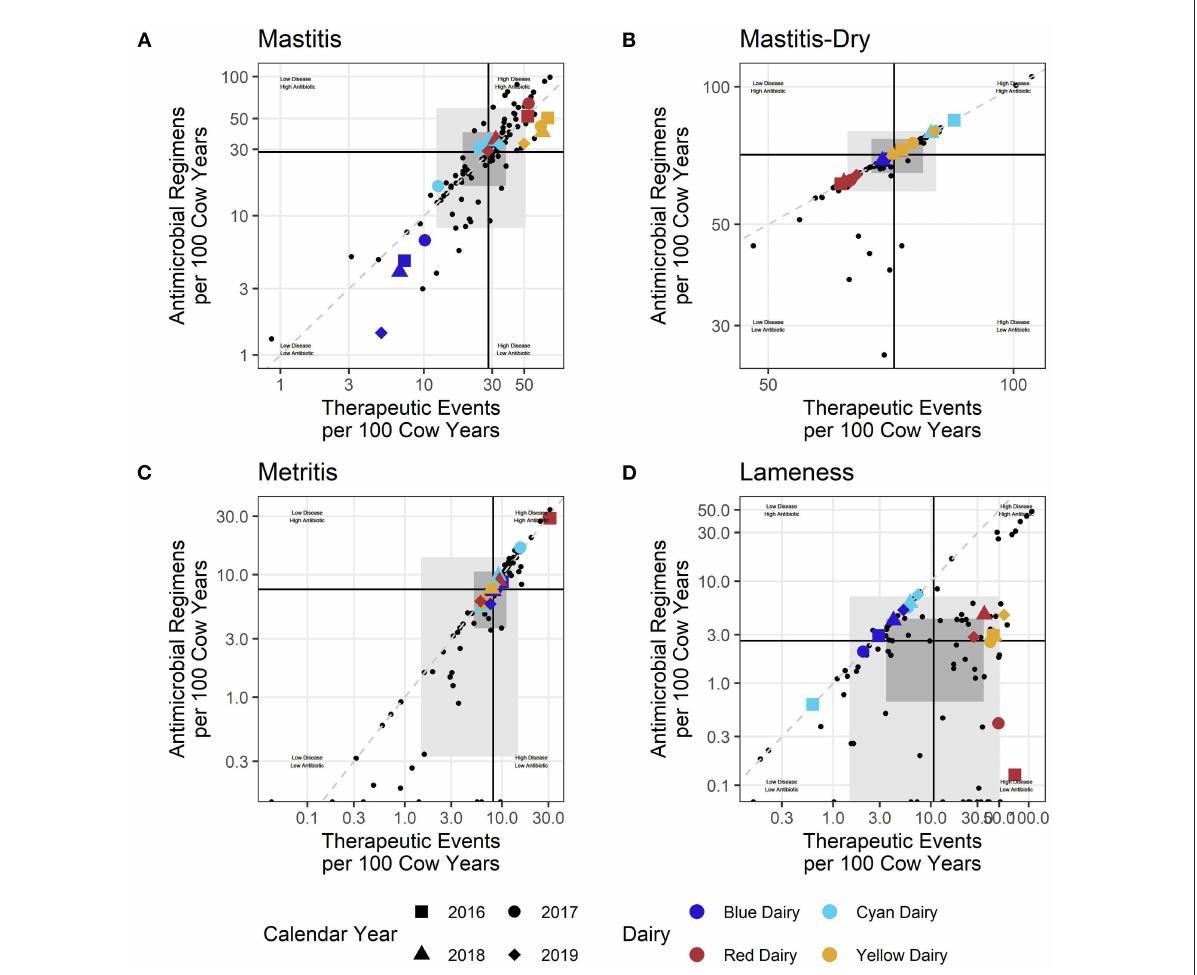
FIGURE2 (A–D) Each small dot represents an individual dairy during one calander year/Shaded rectangles represent the middle 50% (dark) and 80% (lighter) of participating dairies. Black lines represent the intersect of the medians (middle value) for the entire dataset. Colored shapes indicate the value of example dairies and respective calendar